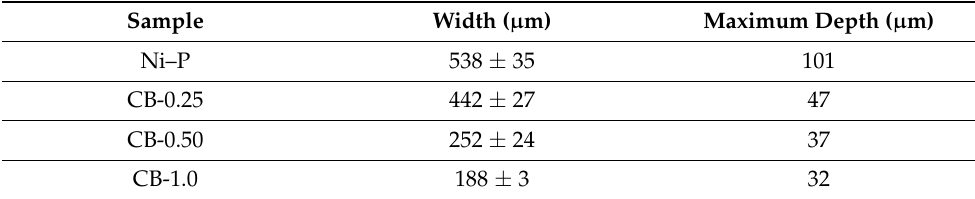
Table 2. Scratch dimensions of the Ni–P and Ni–P/MWCNT